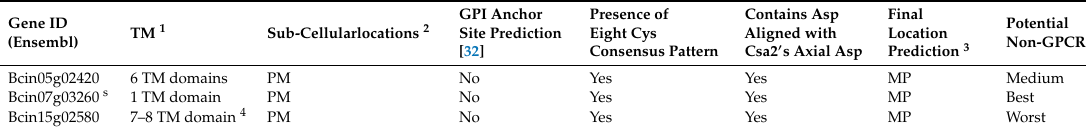
Table 1. Computational identification and characterization of CFEM-containing protein coding genes, which are associated with the membrane (Materials and